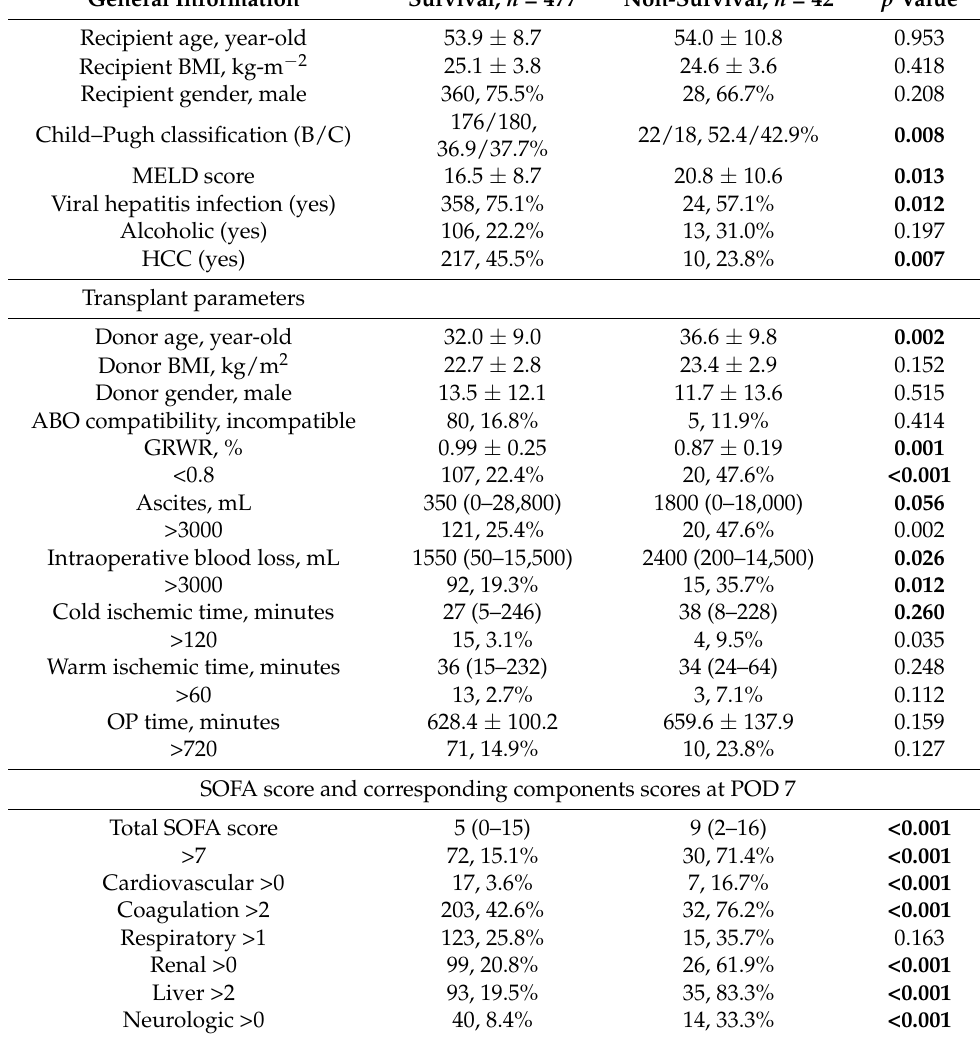
Table 2. A comparative study (demographics) according to 3-month survival after transplant. General